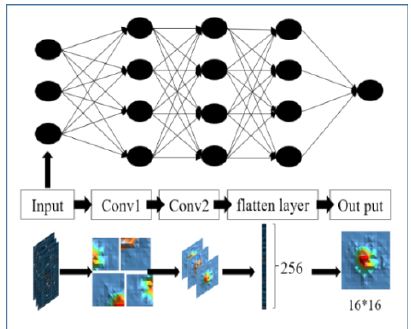
Figure 3. The structure of the neural network.